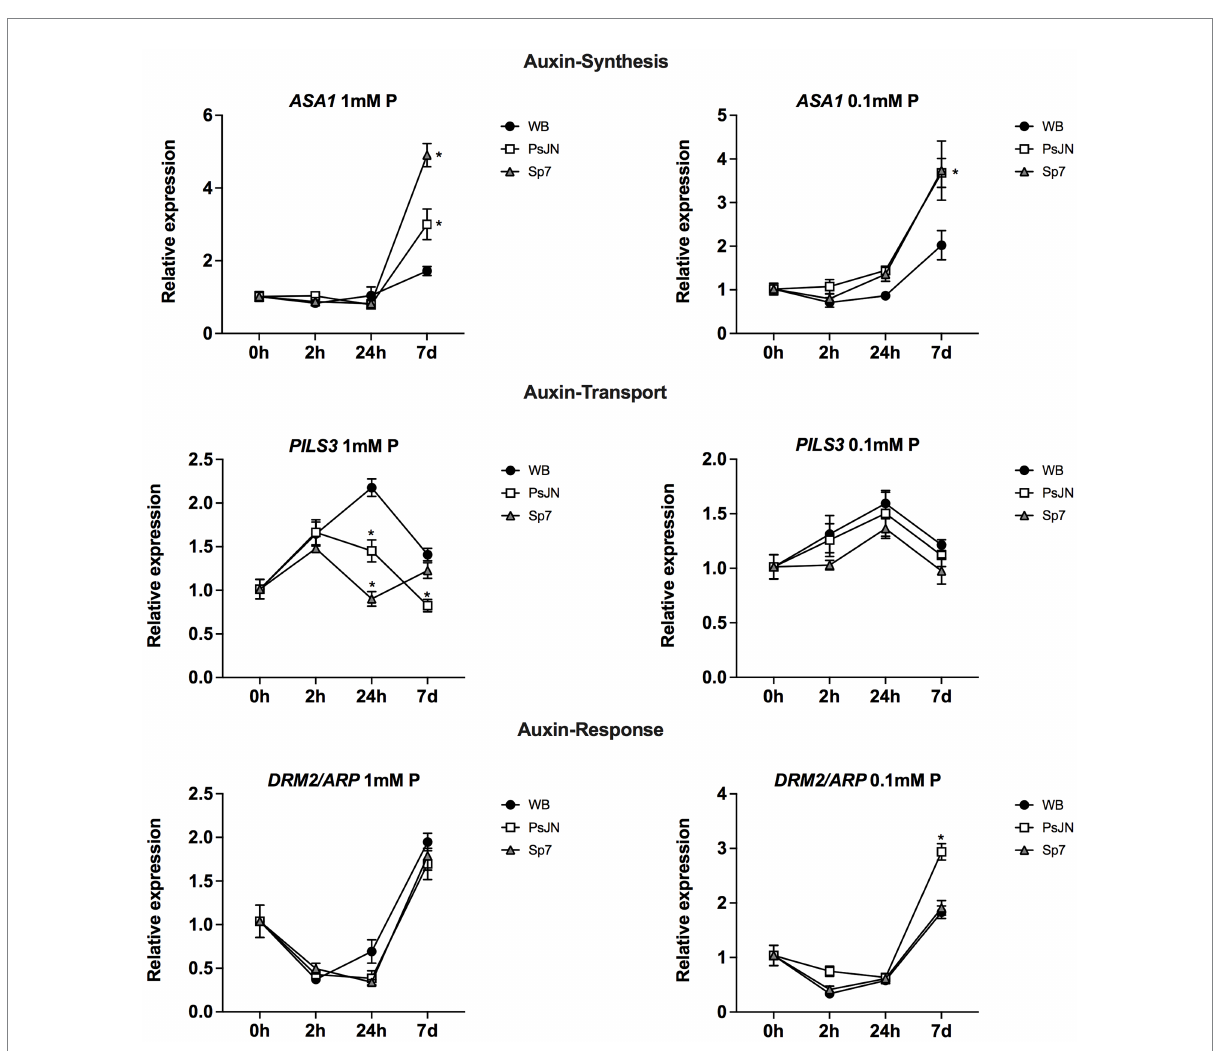
FIGURE 8 Effects of beneficial bacteria on auxin-related genes in Arabidopsis thaliana grown in different phosphate sources. Quantitative RT-PCR determinations of relative expression levels of the genes related to auxin synthesis ASA1 ( ANTHRANILATE SYNTHASE ALPHA SUBUNIT 1 ); transport PILS3 ( PIN-LIKES 3 ), and response DRM2/ARP1 ( DORMANCY ASSOCIATED GENE-1/AUXIN-REPRESSED PROTEIN ). Plants were exposed to 1 mm KH 2 PO 4 /0 mM Ca 3 PO 4 (Left panel) or 0.1 mm KH 2 PO 4 /0.99 mM Ca 3 PO 4 (right panel) for 0, 2, 24 h or 7 days (d). Simultaneously, plants were non- inoculated (WB) or inoculated with Paraburkholderia phytofirmans PsJN (PsJN) or Azospirillum brasilense Sp7 (Sp7). Normalization was performed with the housekeeping SAND family gene (AT2G28390). Asterisks indicate statistical significance among treatments in a particular time compared to the WB group (Two-way ANOVA and multiple comparisons, p <